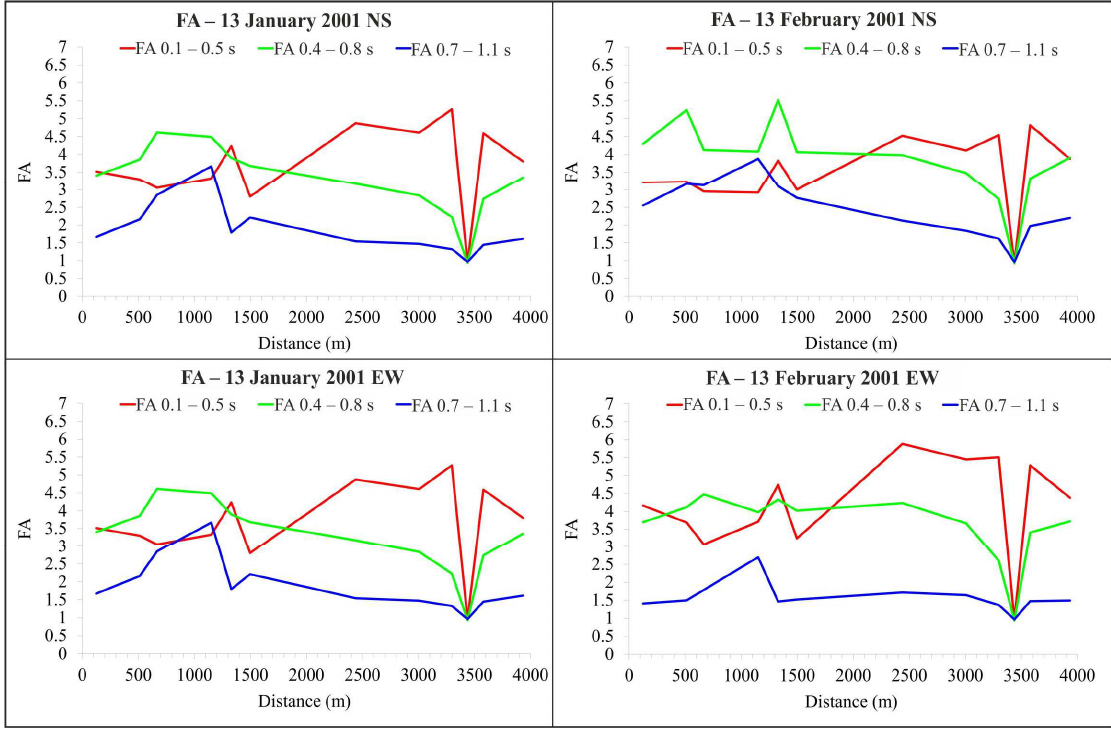
Figure 12. Calculated FA values along the section BB’, related to three period ranges (0.1–05 s, 0.4– 0.8 s and 0.7–1.1 s), referring to the two components (NS, EW) of the two mainshocks on 13 Janu- ary and 13 February 2001.